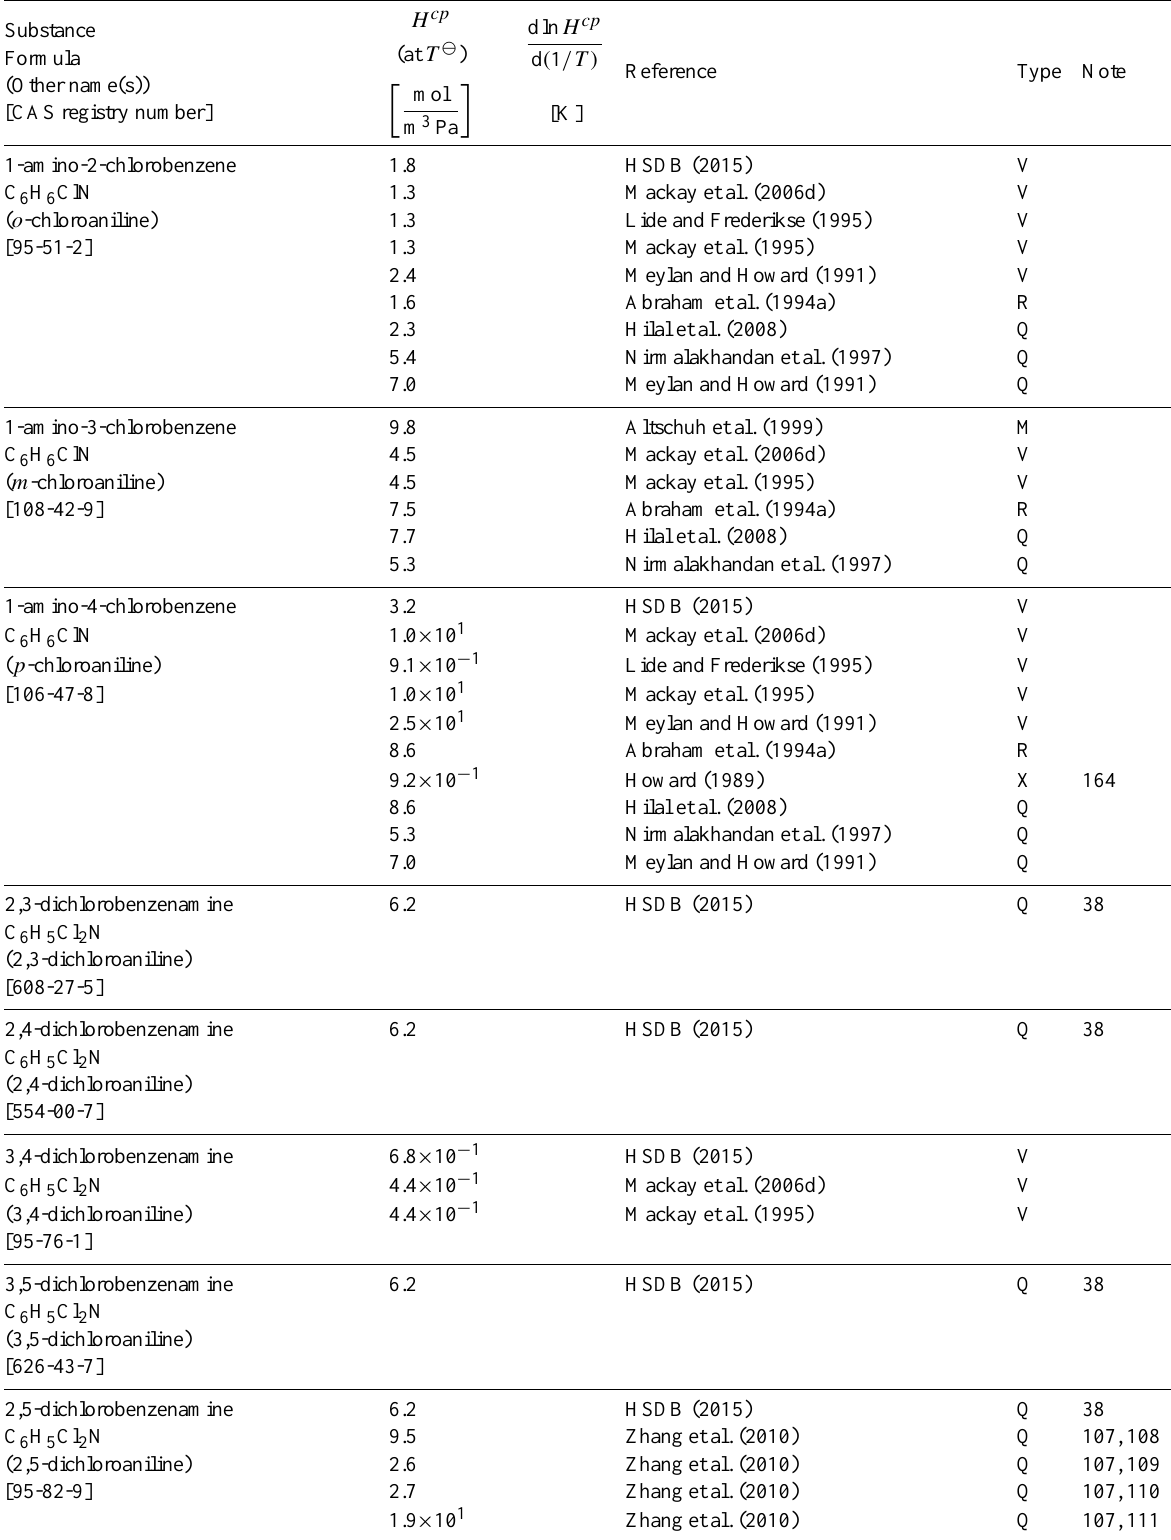
Table 6: Henry’s law constants for water as solvent